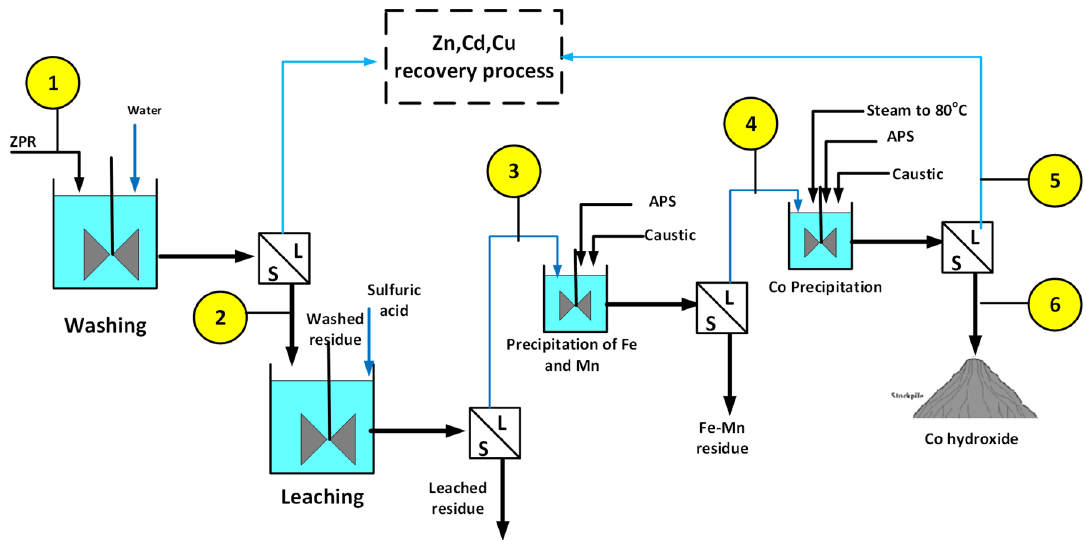
Figure 10. ZPR processing circuit to extract cobalt (See Table 10 for the composition of streams